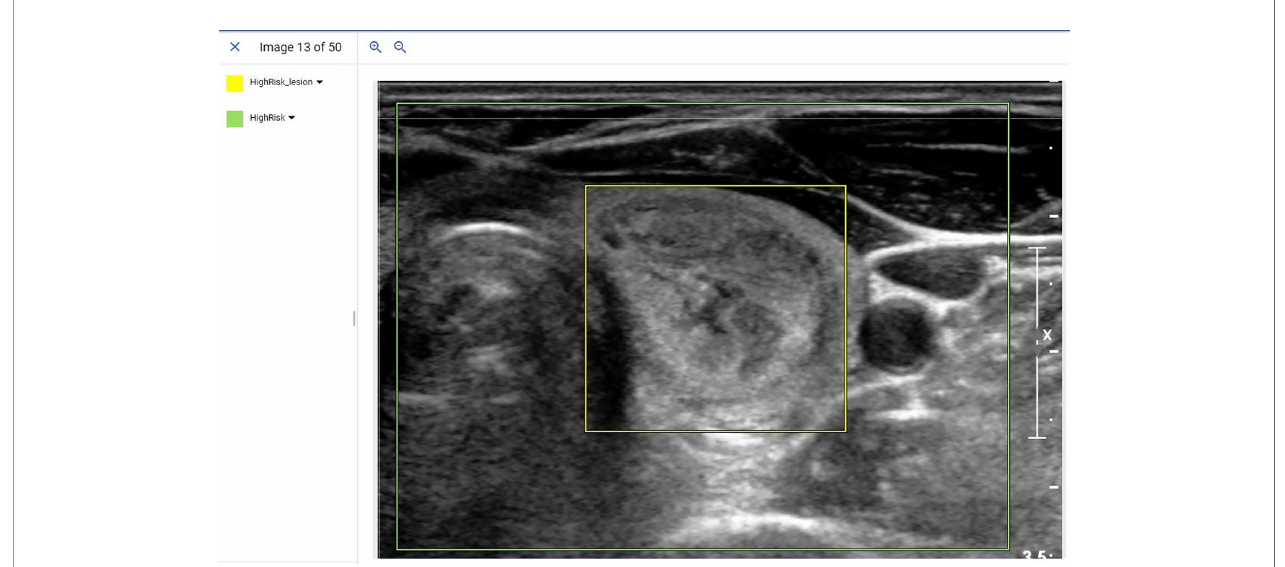
FIGURE 1 | Example of a de-identi fi ed image being input into the AutoML object detection model. In this example, radiologists used bounding boxes to mark the location of the lesion (Yellow bounding box) and overall image (Green bounding box). The label was assigned with bounding boxes where the yellow bounding box indicated a high-risk lesion and the green bounding box indicated an ultrasound image that contained a high-risk